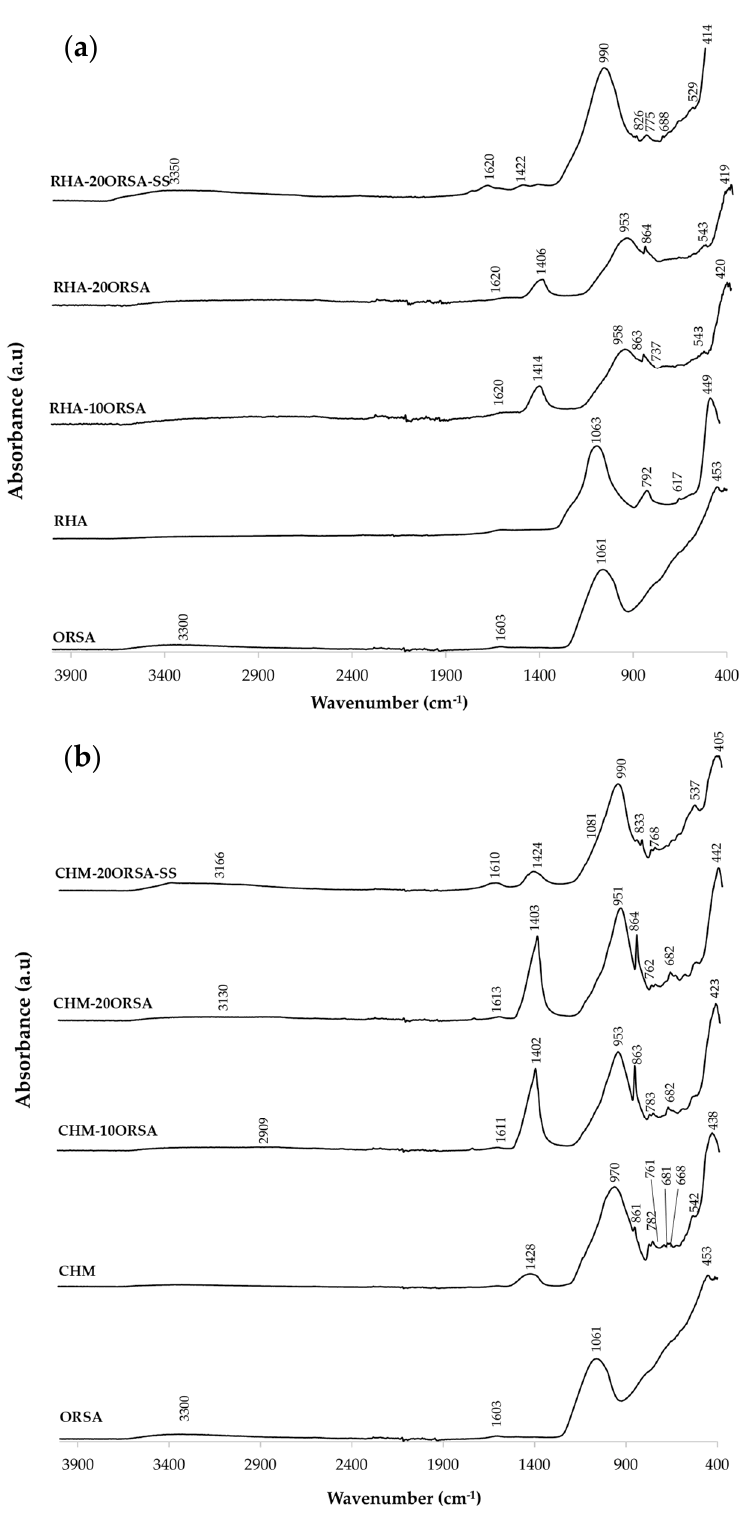
Figure 8. FTIR spectrum of ( a ) RHA-xORSA geopolymers and ( b ) CHM-xORSA geopolymers at 28 days of curing.